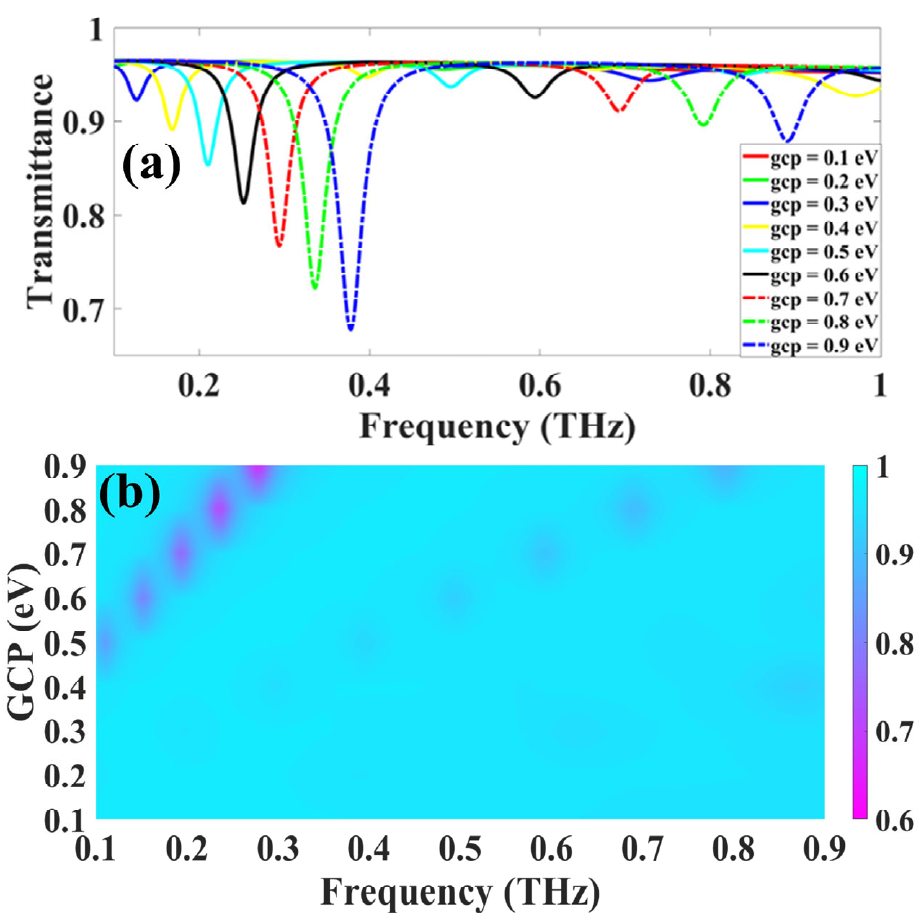
Figure 2. GCP affecting the transmittance plots, ( a ) line plot exhibiting the gradual drop in transmittance as the GCP enhances from 0.1 eV to 0.9 eV in a uniform rise of 0.1 eV, ( b ) color plot exhibiting the right shift in transmittance drops with the increment of GCP. Furthermore, it is noticed that the transmittance drop is not observable for 0.1 eV and 0.2 eV. While for rest of the GCPs, we attain two spectrums, one at around 0.3 THz and the other after 0.4 THz. Though the transmittance drop is not very significant for the second spectrum hence for the purpose of this study, we have considered the first spectrum of 0.3 THz. The highest transmittance drop is demonstrated at 0.9 eV at 0.378, and a drop of 67.33% is observed.